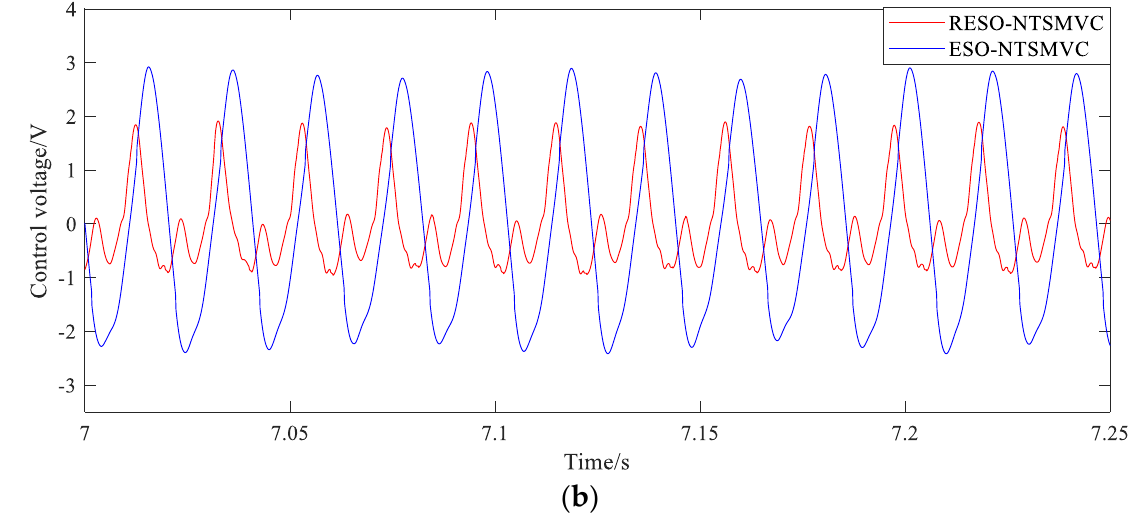
Figure 7. Experimental control voltage curves: ( a ) global curves; ( b ) local curves. Table 3. Vibration control effect of different controllers.